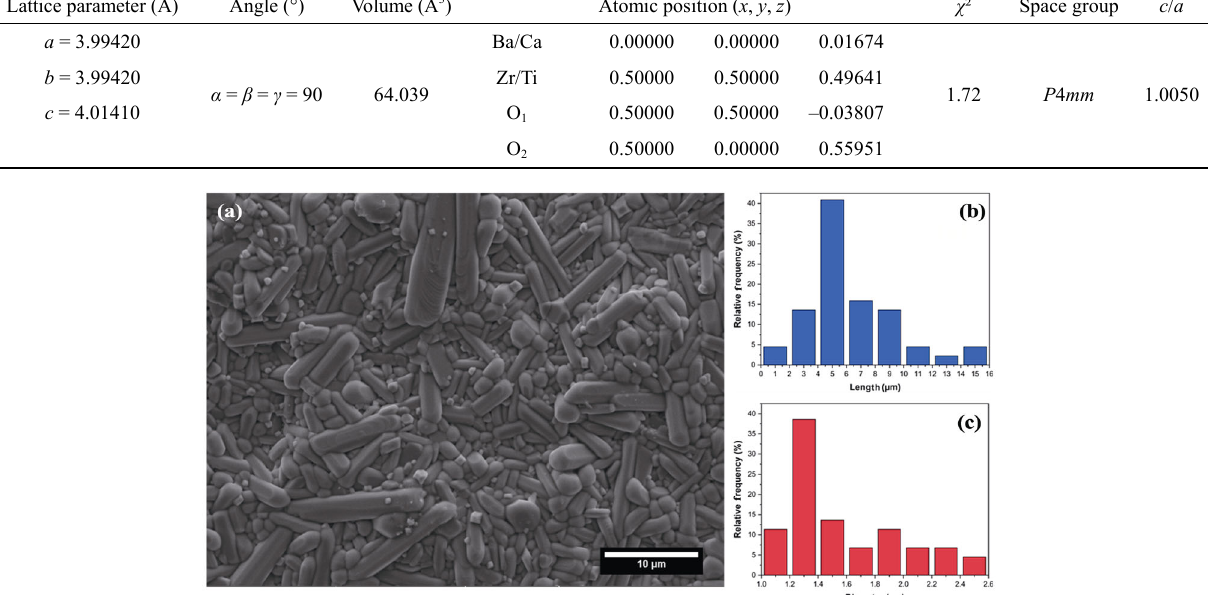
Table 1 Structural parameters obtained from Rietveld refinement of BCZT calcined powder Lattice parameter (Å)